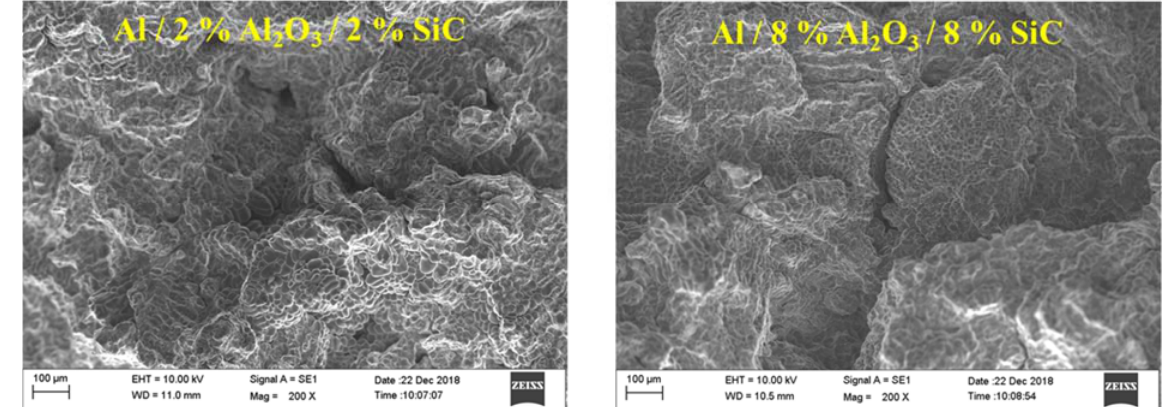
Figure 5: Fracture images of ice quenched composites with different compositions.